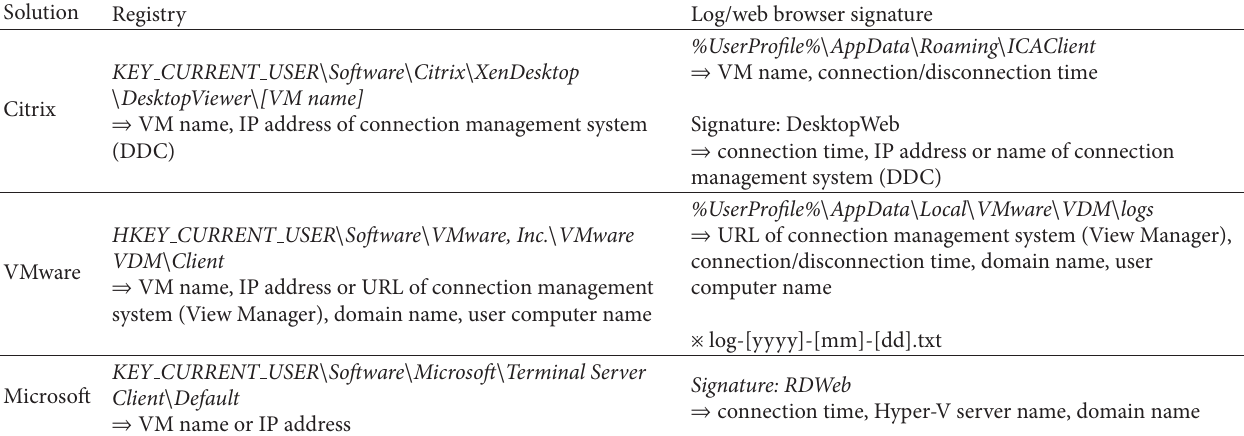
Table 3: Access information for a virtual machine logged in the local Windows